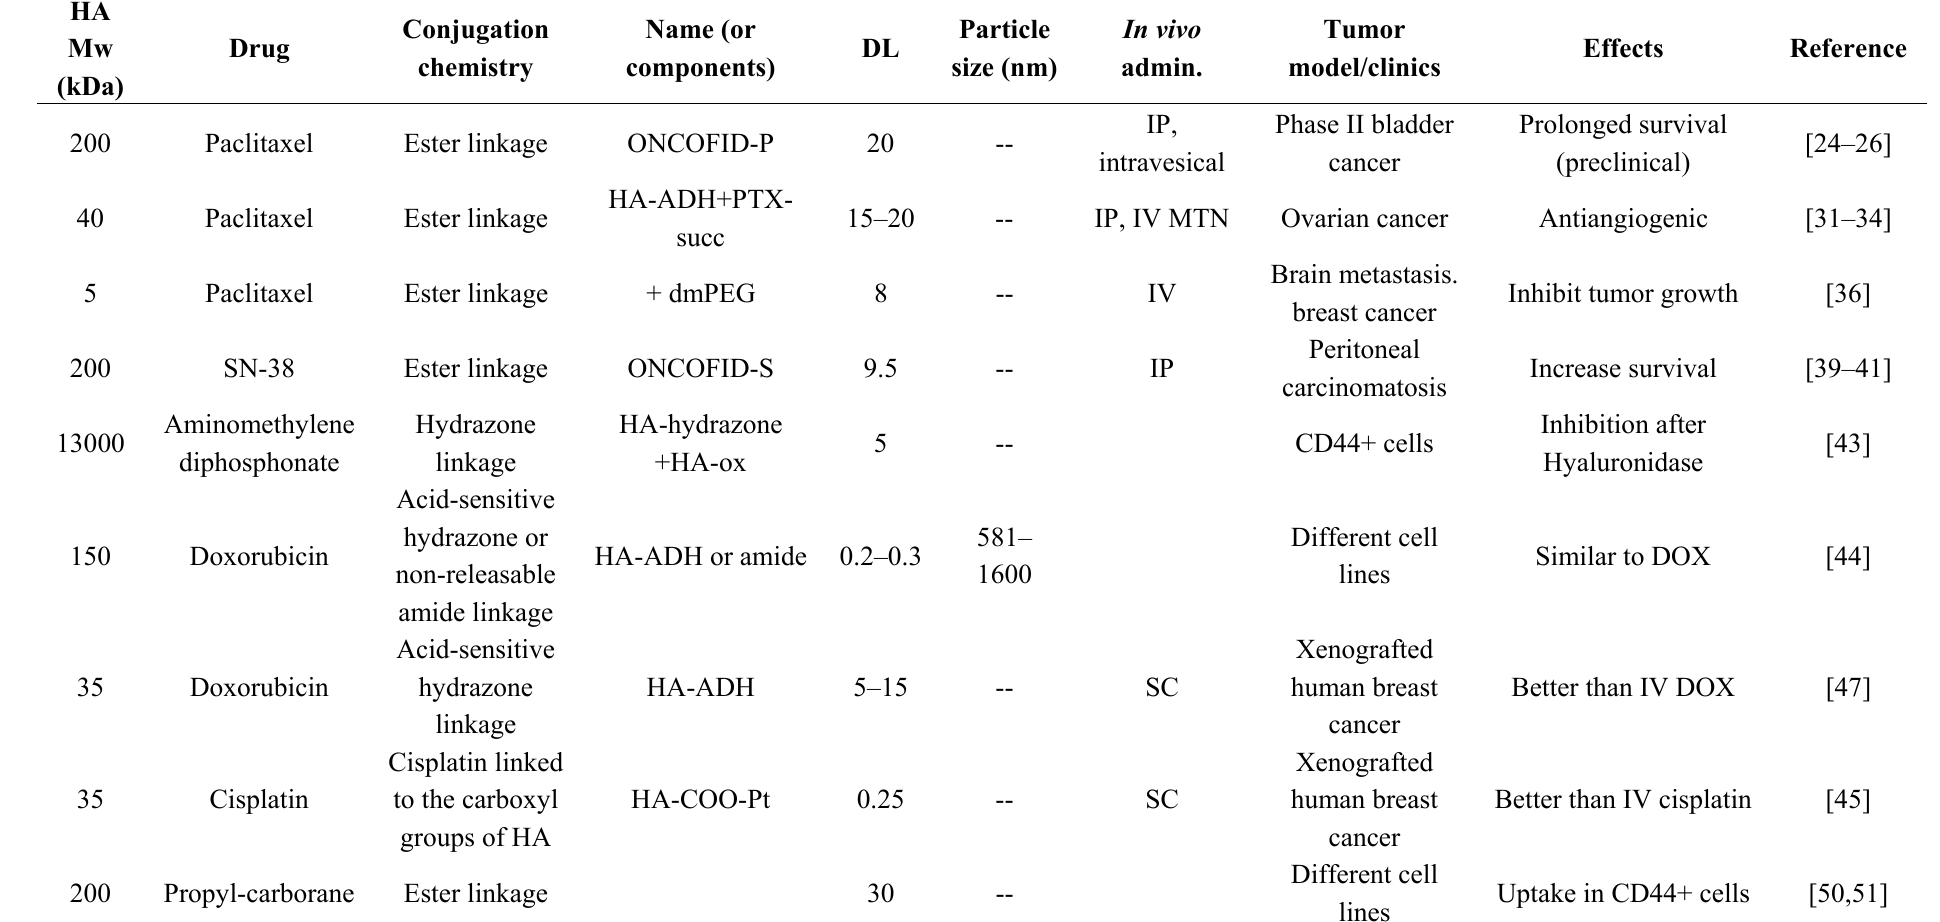
Table 1. Summary of the characteristics of the principal HA-drug